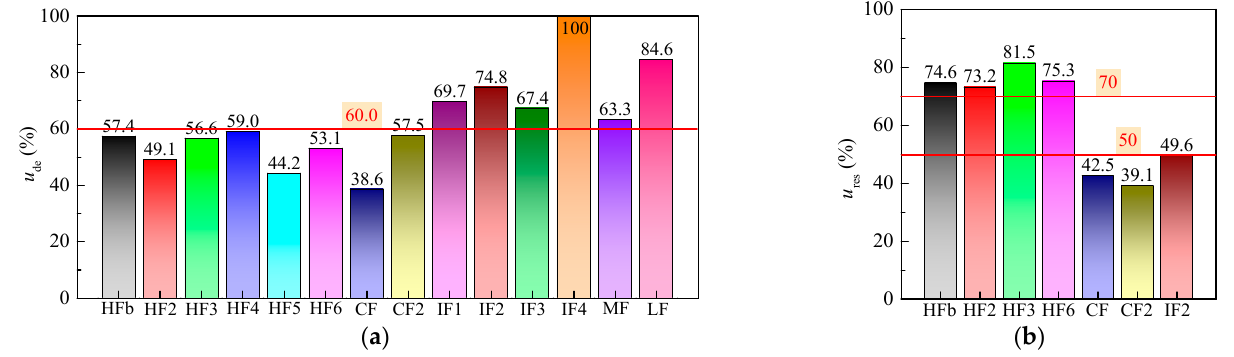
Figure 13. The strength ratios of different deformed steel fibers: ( a ) u de ; ( b ) u res .